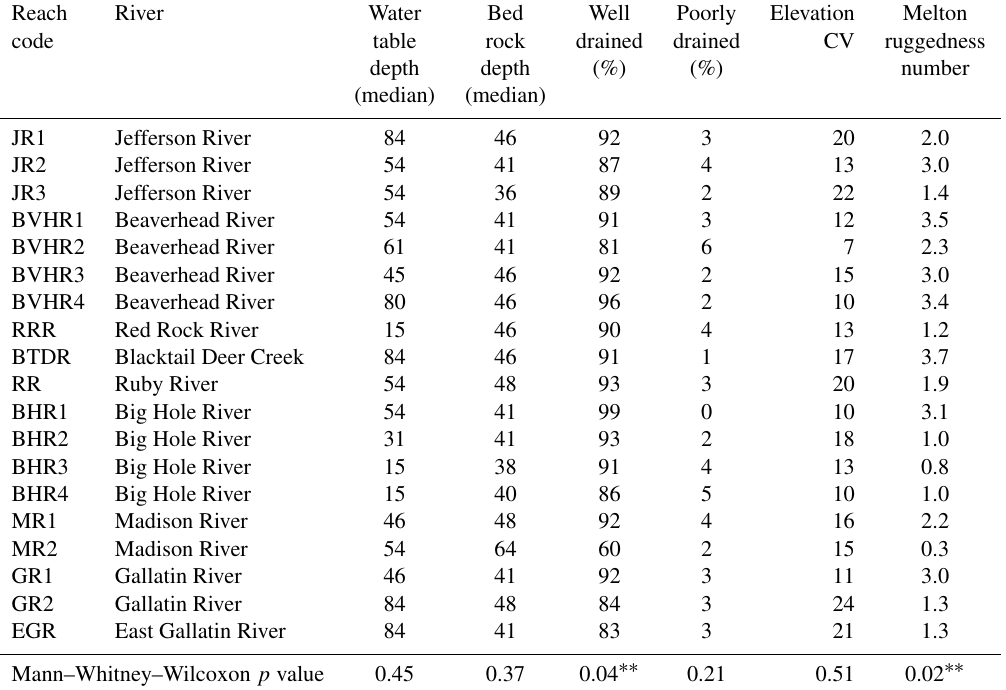
Table 6. Characteristics of riparian reach contributing areas, including median water table depth (m), median bedrock depth (m), percentage of well-drained (or very well drained) soil, percentage of poorly (or very poorly) drained soil, elevation coefficient of variation (CV) and Melton ruggedness number. The Mann–Whitney–Wilcoxon test was used to calculate a measure of the difference (or lack of) between riparian reaches that showed a significant non-climate-related drying over time (shaded gray) and riparian reaches that showed no such pattern, with two asterisks indicating a significant difference ( p < 0 . 05) between the two